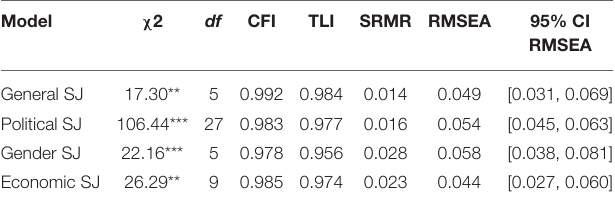
TABLE 5 | The results of CFAs for Study 3.